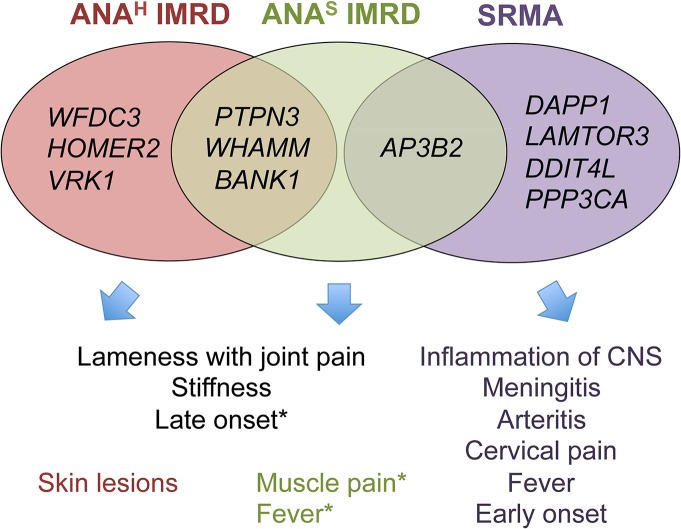
Venn diagram showing overlaps between clinicopathologic features and associated genes.* Muscle pain and fever occur in both ANA-positive groups, but were slightly more frequent in ANAS dogs in the study cohort. ANAS showed an earlier onset of disease than ANAH (2 versus 3 years), while SRMA affected dogs at even a younger age (4–19 months).